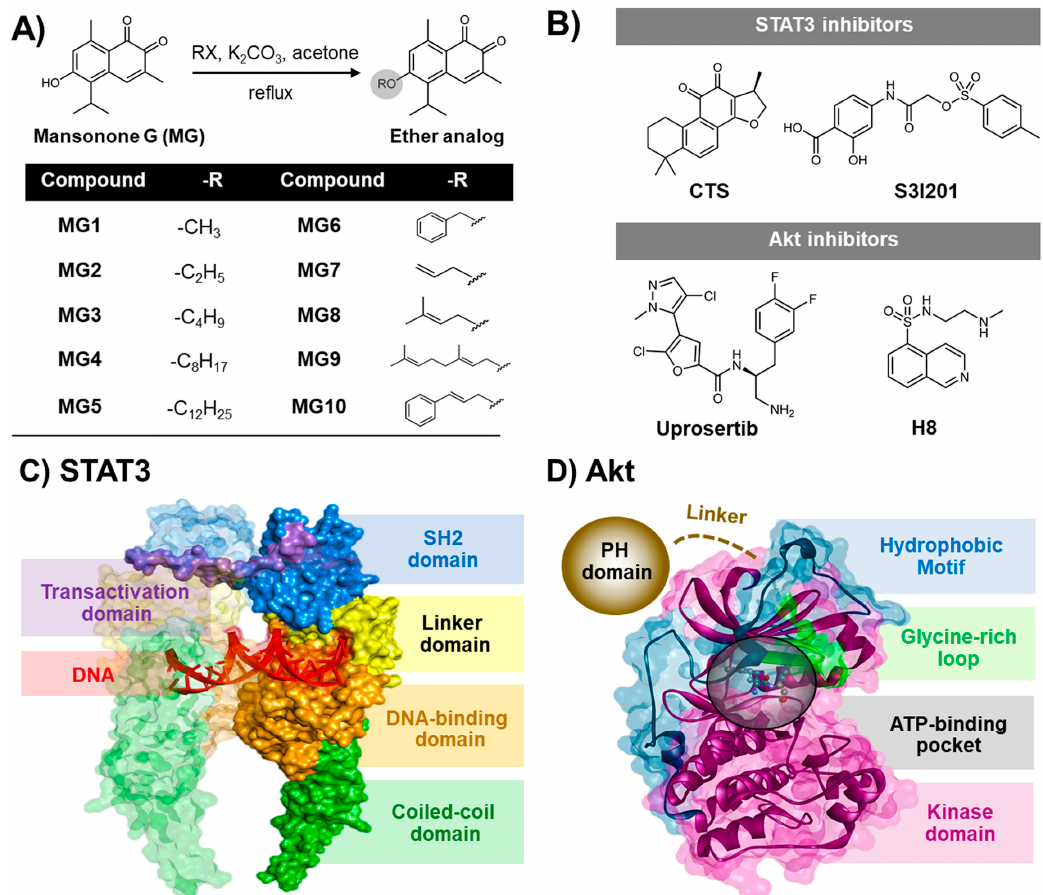
Figure 1. Two-dimensional (2D) chemical structures of ( A ) MG and its semi-synthetic ether derivatives MG1-MG10 [30] and ( B ) the known STAT3 (cryptotanshinone (CST) and S3I201) and Akt (uprosertib and H8) inhibitors. Three-dimensional (3D) structures of ( C ) STAT3 and ( D ) Akt1 signaling proteins. The SH2 domain of STAT3 and the ATP-binding pocket of Akt are shown by blue surface and black circle, respectively.